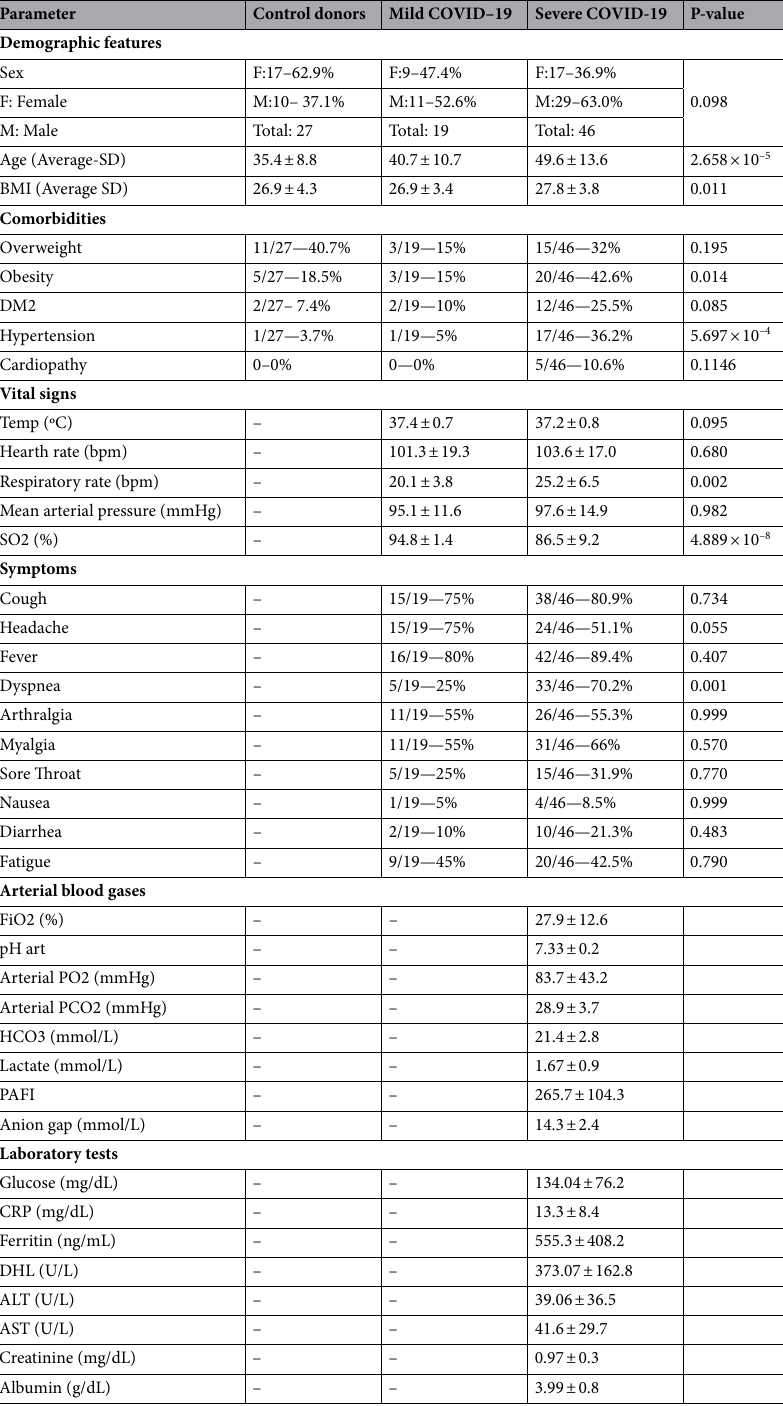
Table 1. Demographic, clinical, and laboratory parameters of the participants. P -value for Kruskal–Wallis, U, c χ 2 or Fisher exact